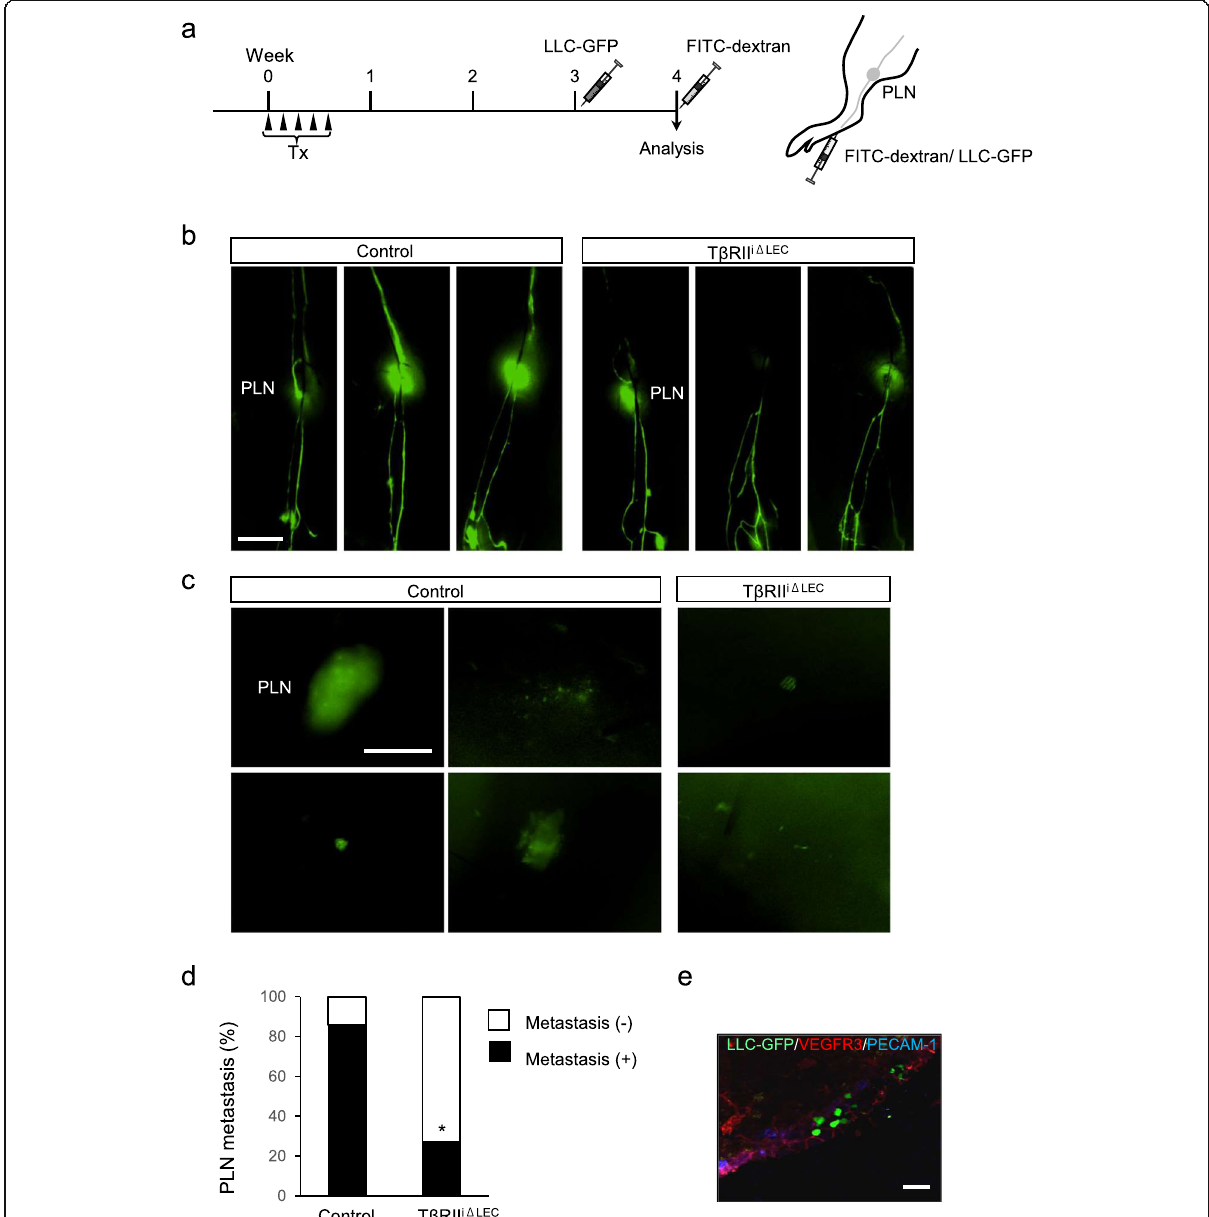
Fig. 3 T β RII i Δ LEC mice exhibit decreased lymphatic drainage and tumor lymphatic metastasis. a . The mice were intraperitoneally administered Tx for five consecutive days. Three or 4 weeks later, LLC-GFP or FITC-dextran respectively were subcutaneously injected into their rear footpads independently. b Representative images of lymph flow from the lower extremities to the popliteal lymph node (PLN). ( n = 7 mice per genotype) Scale bar: 5 mm. c Representative images of LLC-GFP metastasized to the PLN. Scale bar: 500 μ m. d Quantification of metastasis (black) and no metastasis (white) to the PLN. Scale bar: 200 μ m. (control; n = 7, T β RII i Δ LEC ; n = 11) e Immunohistostaining of the sagittal section of PLN from control mice with anti-VEGFR3 (red) and anti-PECAM-1 (blue) antibodies. Green fluorescence was derived from LLC-GFP. Scale bar: 100 μ